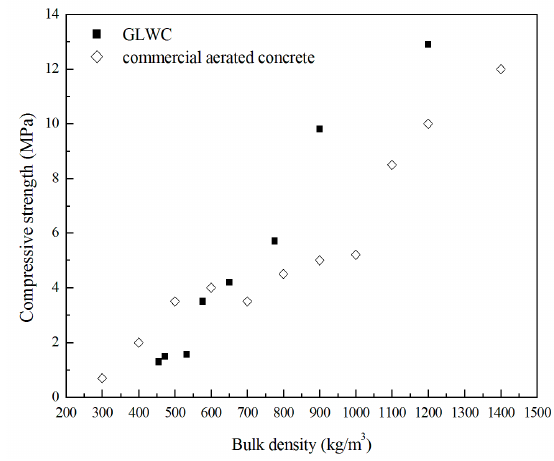
Figure 5. Compressive strength vs. bulk densities of GLWC after curing for 28 days.